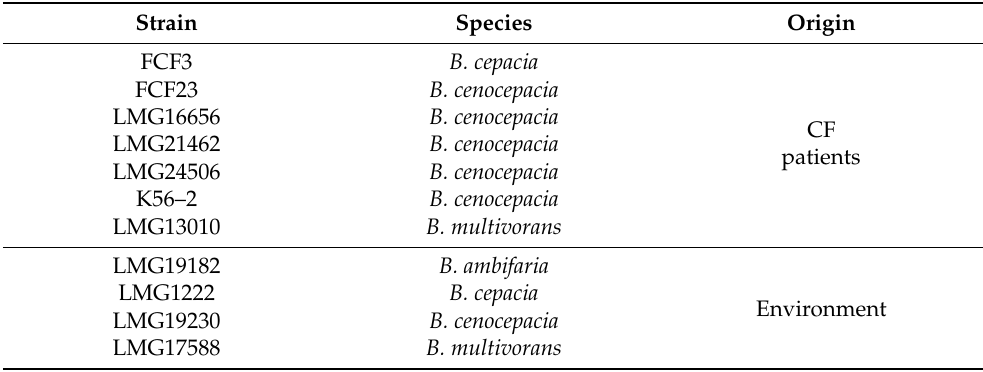
Table 1. Target bacterial strains that belong to the Burkholderia cepacia complex used in this work. Strain Species Origin